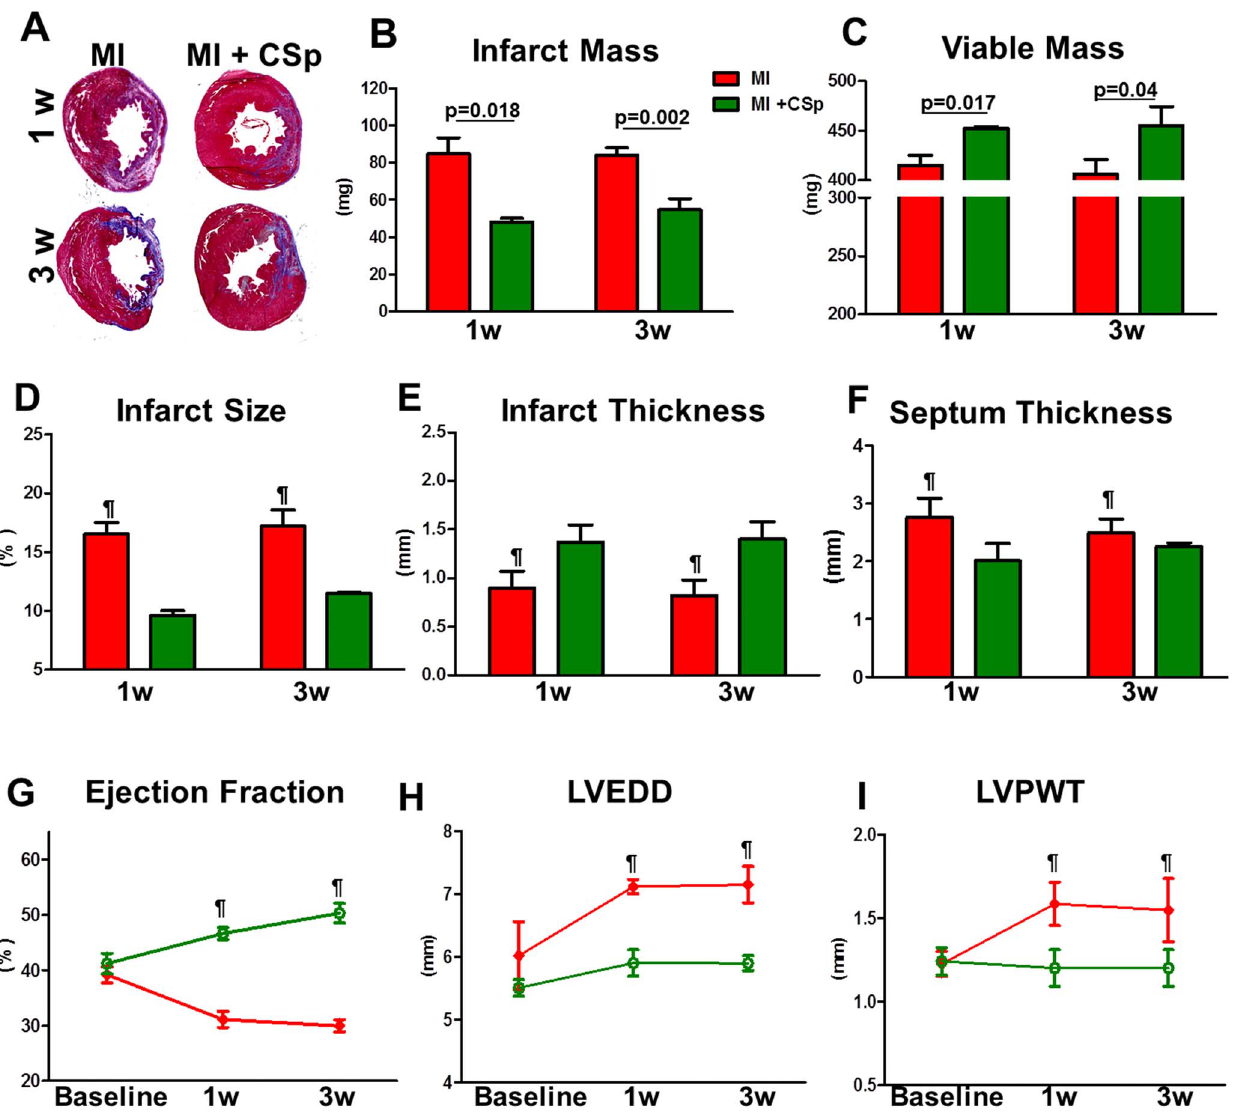
Figure 1. Tissue morphology and cardiac function. (A) Representative photomicrographs of myocardial sections stained with Masson’s trichrome. Sections are from CSp treated (n=5) and placebo treated (n=5) animals at 7 and 21 days post MI and treatment. (B–F) Quantitative data for infarct mass, viable mass, infarct size, infarct thickness and septum thickness. Five different hearts were processed and 5–6 different sections from the apex to the base from each heart were used for the analysis. (G–I) EF ejection fraction, LVEDD left ventricular end diastolic diameter, LVPWT left ventricular posterior wall thickness in diastole. Baseline represents measurements 18–24 hours after coronary ligation and treatment. n=6 for each animal group studied. Bars are presented as mean 6 SD. " p , 0.05 control vs MI +